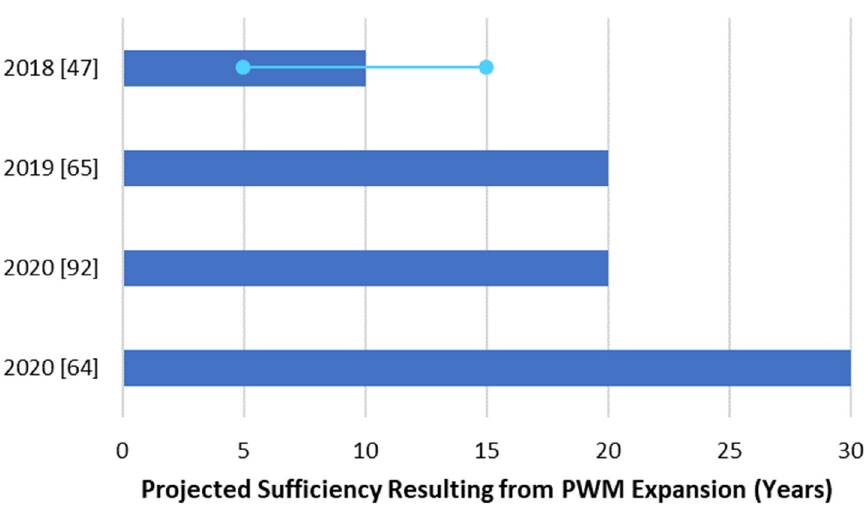
Figure 10. Estimates of how long the Pure Water Monterey Expansion could satisfy water demand on the Monterey Peninsula. Recent estimates reveal significant uncertainty in projected demand.